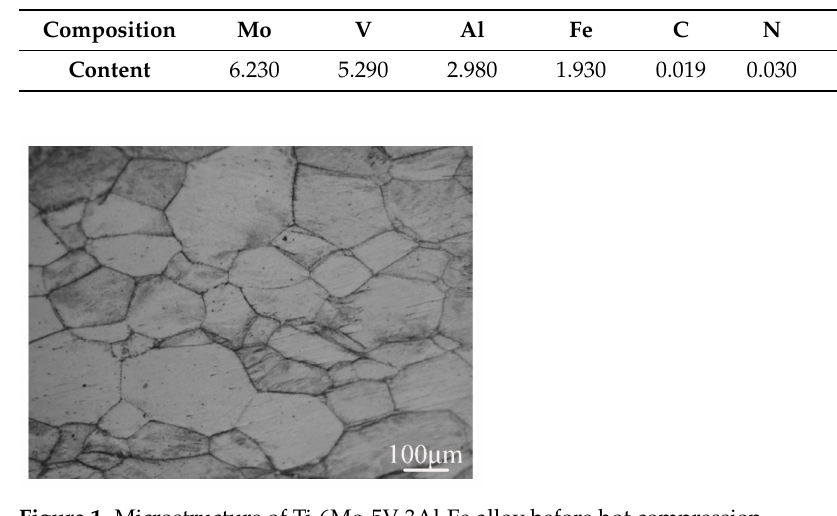
Table 1. Composition of Ti-6Mo-5V-3Al-2Fe alloy.